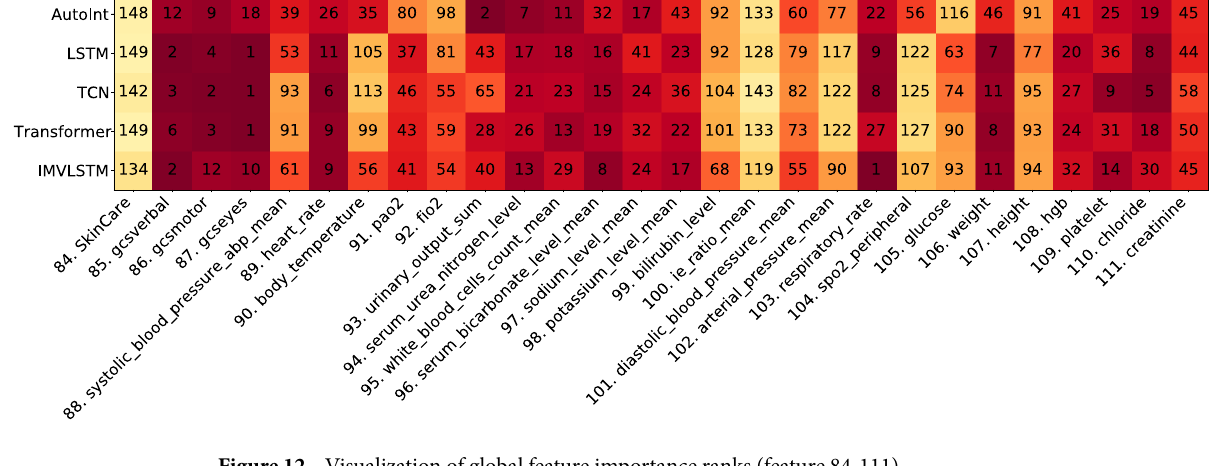
Figure 12. Visualization of global feature importance ranks (feature 84-111).